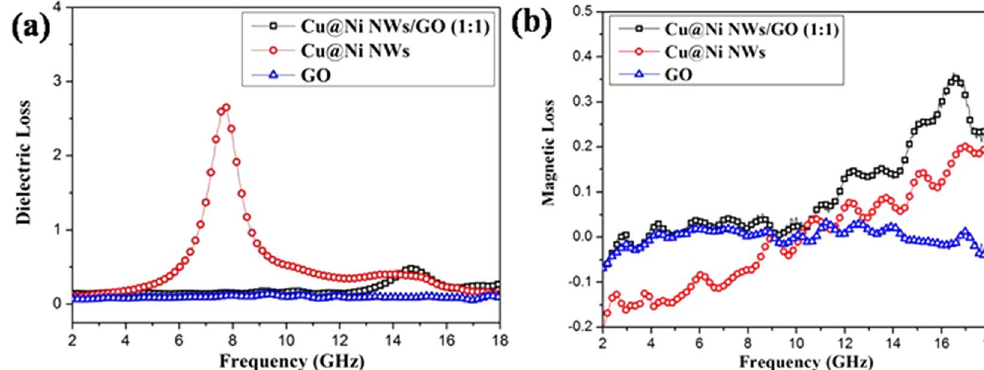
Figure 7. Dielectric loss ( a ) and magnetic loss ( b ) of Cu@Ni NWs/GO (1:1) composite, Cu@Ni NWs, and GO.